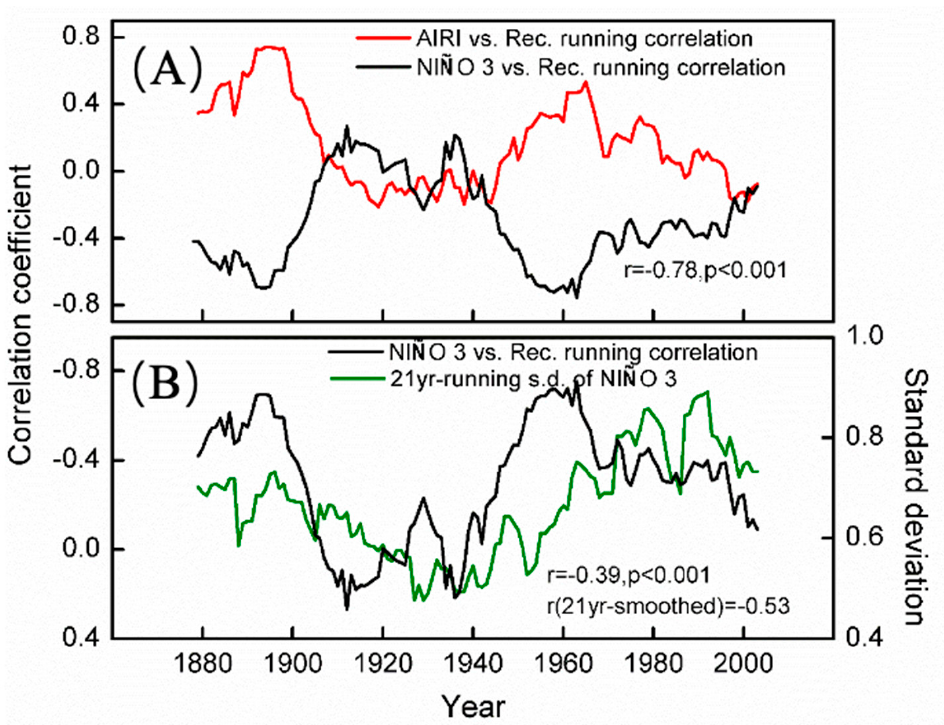
Figure 13. ( A ) The 21-yr sliding-window correlation (red line) between the reconstruction and all Indian Rainfall index, compared with the 21-yr sliding-window correlation (black line) between the reconstruction and the NIÑO3 SST index, ( B ) the 21-yr sliding-window correlation (black line) between the reconstruction and the NIÑO3 SST index, compared with the 21-yr running standard deviation of NIÑO3 SST index.